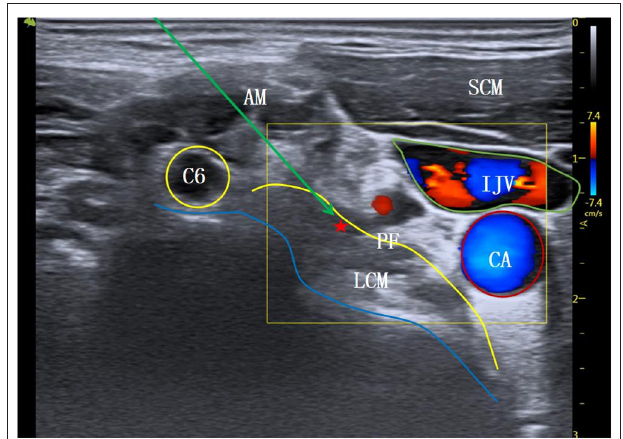
FIGURE 2 | Modified inferior C6 transverse process level. AM, anterior scalene muscle; SCM, sternocleidomastoid muscle; C6, the 6th cervical nerve root; PF, anterior vertebral fascia; LCM, long neck muscle; ⋆ Indicates stellate ganglion block area; ց Indicates simulated puncture path; IJV, internal jugular vein; CA, carotid artery.